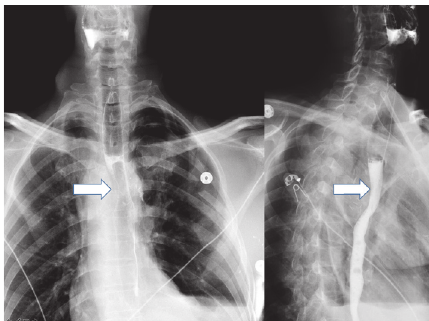
Figure 5: Postoperative barium esophagogram posteroanterior view and lateral view depicting complete resolution of the fixed esophageal narrowing